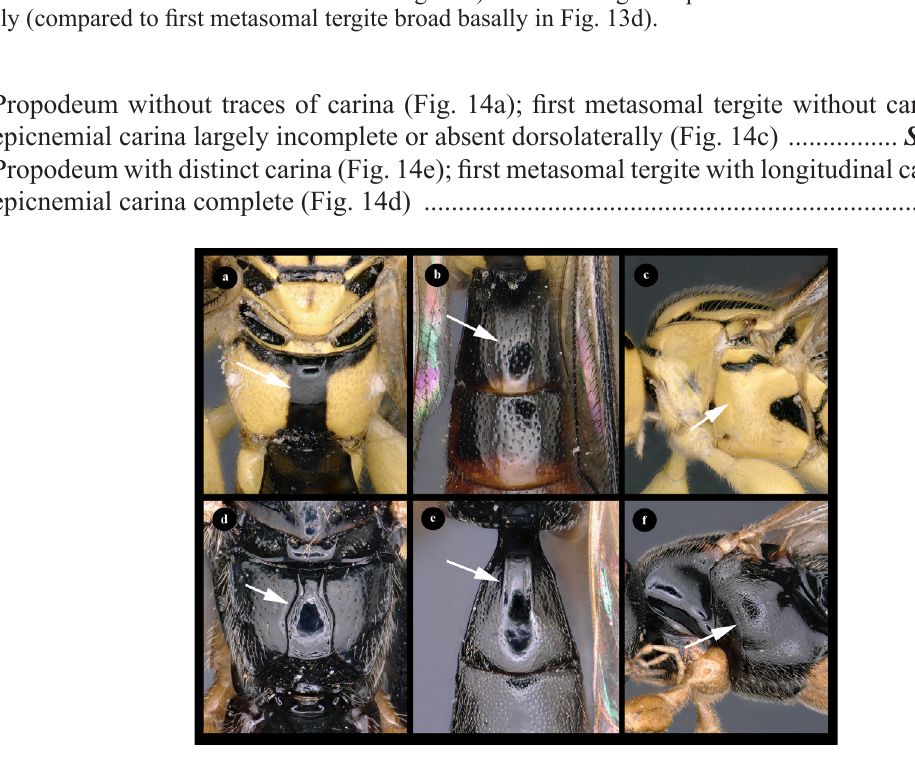
Fig. 14. a–c . Soliga ecarinata gen. et sp. nov. a . Propodeum, dorsal view. b . Metasomal tergites 1–2, dorsal view. c . Mesosoma, lateral view. d–f . Triclistus sp. d . Propodeum, dorsal view. e . Metasomal tergites 1–2, dorsal view. f . Mesosoma, lateral view. Arrow in Fig. 14a points to the absence of propodeal carinae (compared to the presence of propodeal carinae in Fig. 14d). Arrow in Fig. 14b points to the absence of dorsal carinae on first metasomal tergite (compared to the presence of dorsal carinae on first metasomal tergite in Fig. 14e). Arrow in Fig. 14c points to the incomplete epicnemial carina (compared to the complete epicnemial carina in Fig.